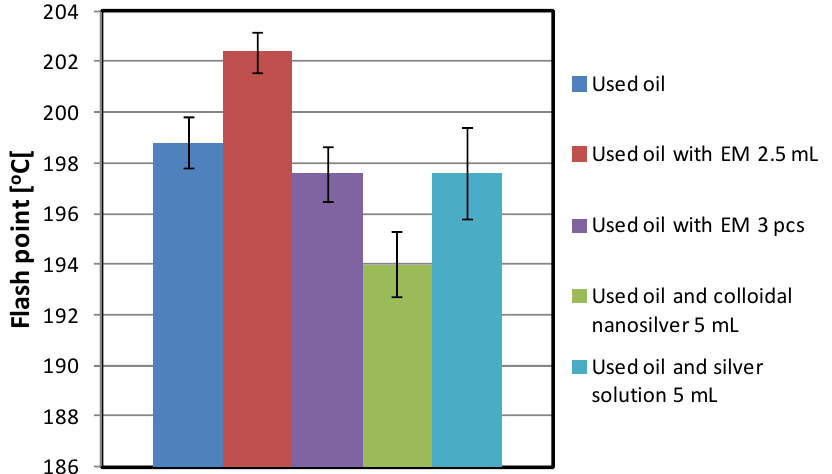
Figure 10. Oil flash point of waste oil and waste oil with effective microorganisms (EM), colloidal nanosilver (CN), and silver solution (SS).